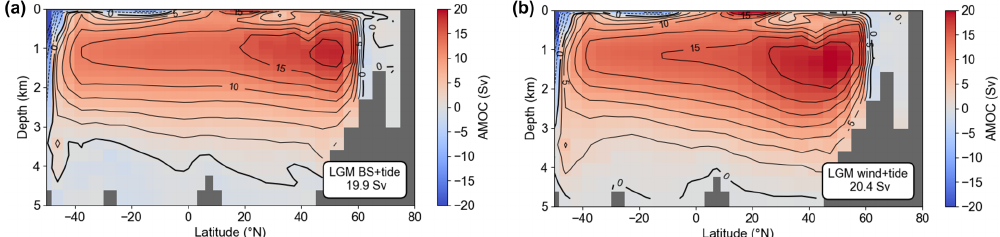
Figure B6. Atlantic stream functions for LGM boundary conditions with (a) closed Bering Strait and consideration of increased tidal dissipation after Wilmes et al. (2019) and (b) added LGM wind stress anomalies from PMIP3 models (Muglia and Schmittner, 2015) and increased tidal dissipation.